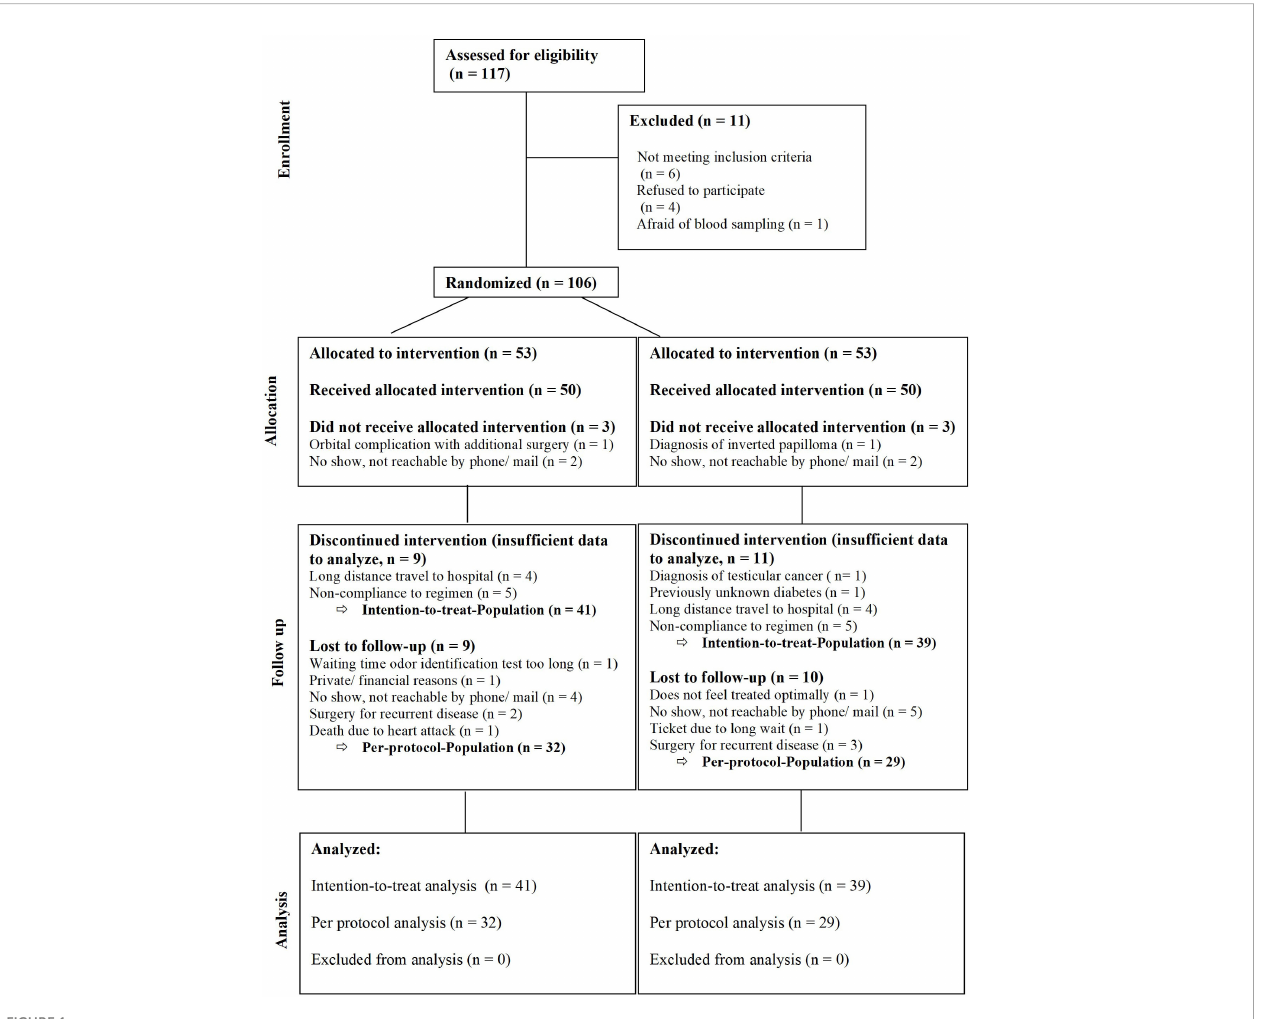
FIGURE 1 CONSORT diagram of the